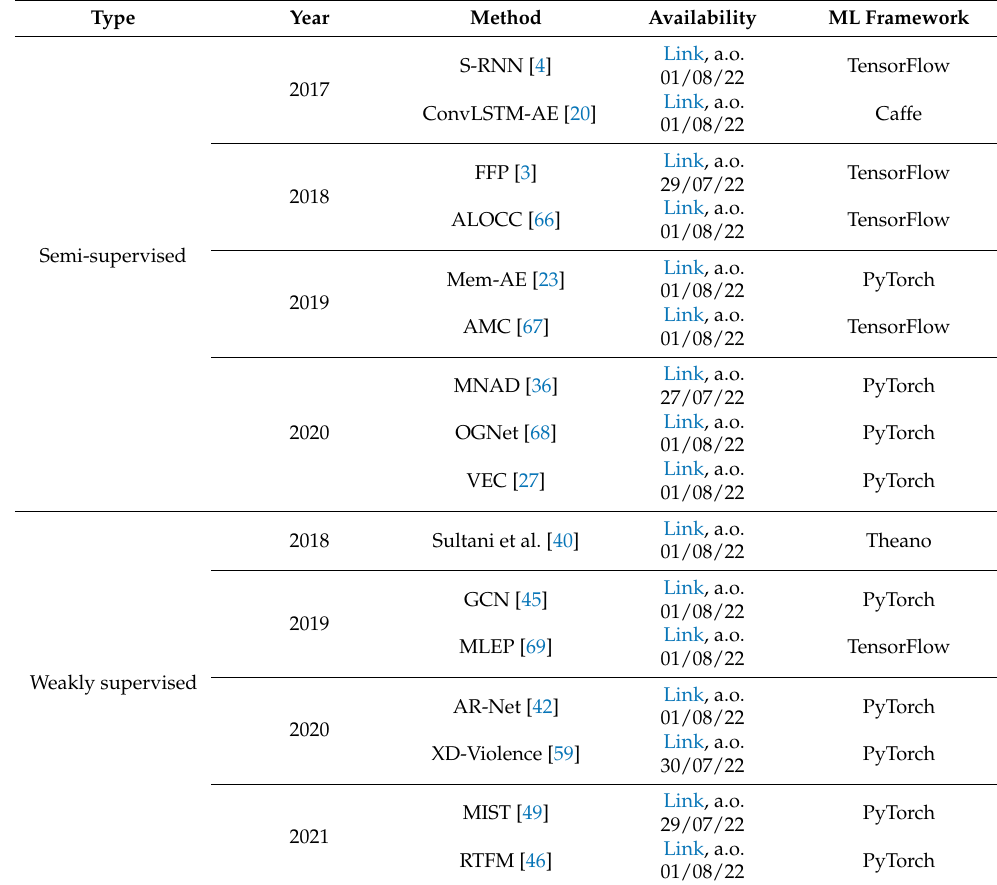
Table 6. Available source code of the surveyed methods, based on the compilation made by Feng et al. [39]. Abbreviation: a.o.—accessed on date (format